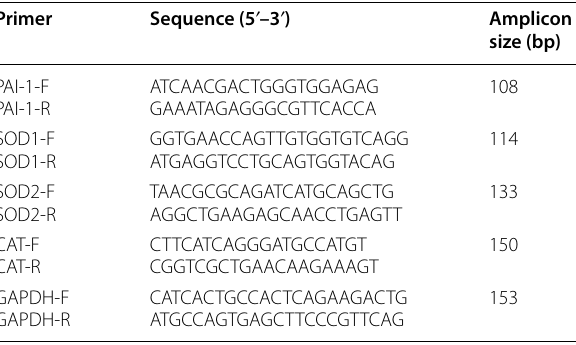
Table 4 Primers used for gene expression